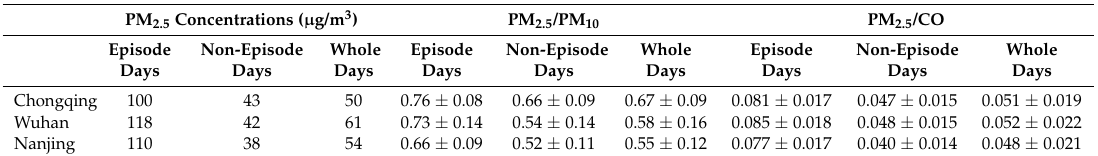
Table 5. Annual mean values with standard deviations of PM 2.5 /PM 10 and PM 2.5 /CO in Chongqing, Wuhan, and Nanjing.